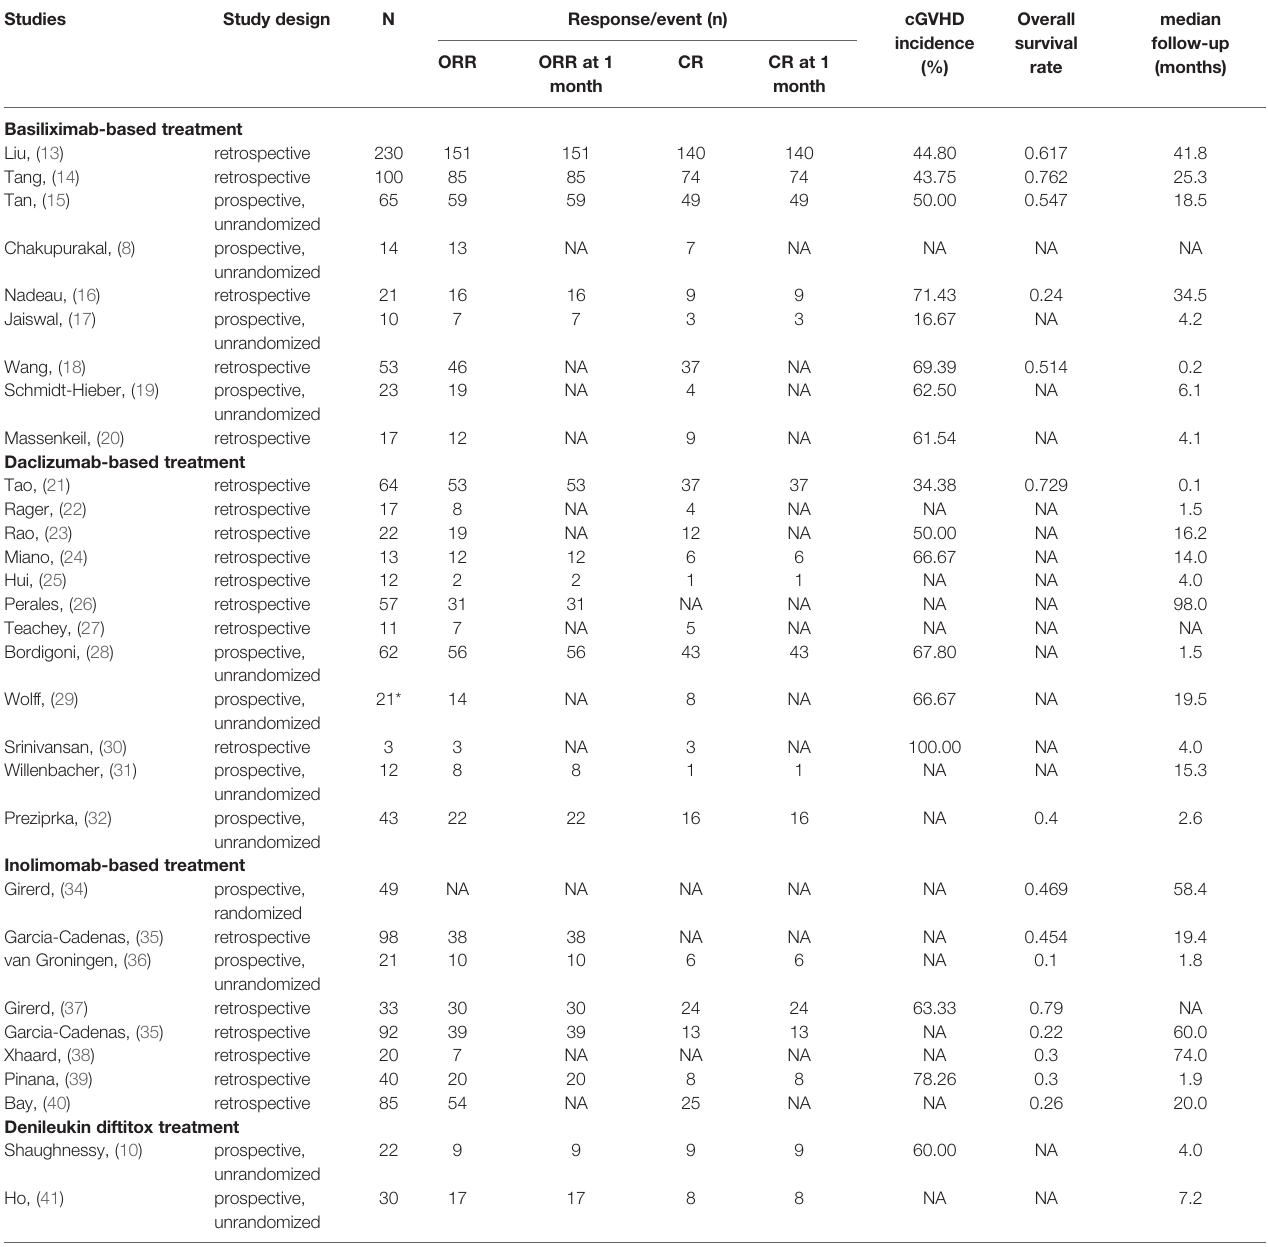
TABLE 1 | Main characteristics of 31 included